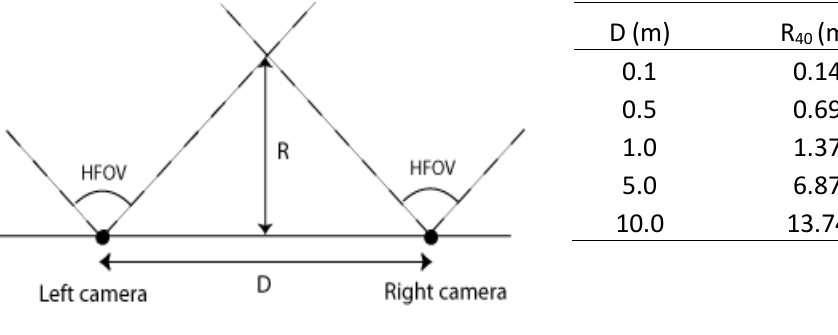
Figure 12. Left: Illustration of stereo vision and overlapping point with D the baseline length, R the distance to the overlapping point of both camera views having an angle HFOV. Right: Distance R to the point where overlap occurs with stereo vision for cameras with HFOV of 40 (R ) and 50 degrees (R ) for specific D 40 50